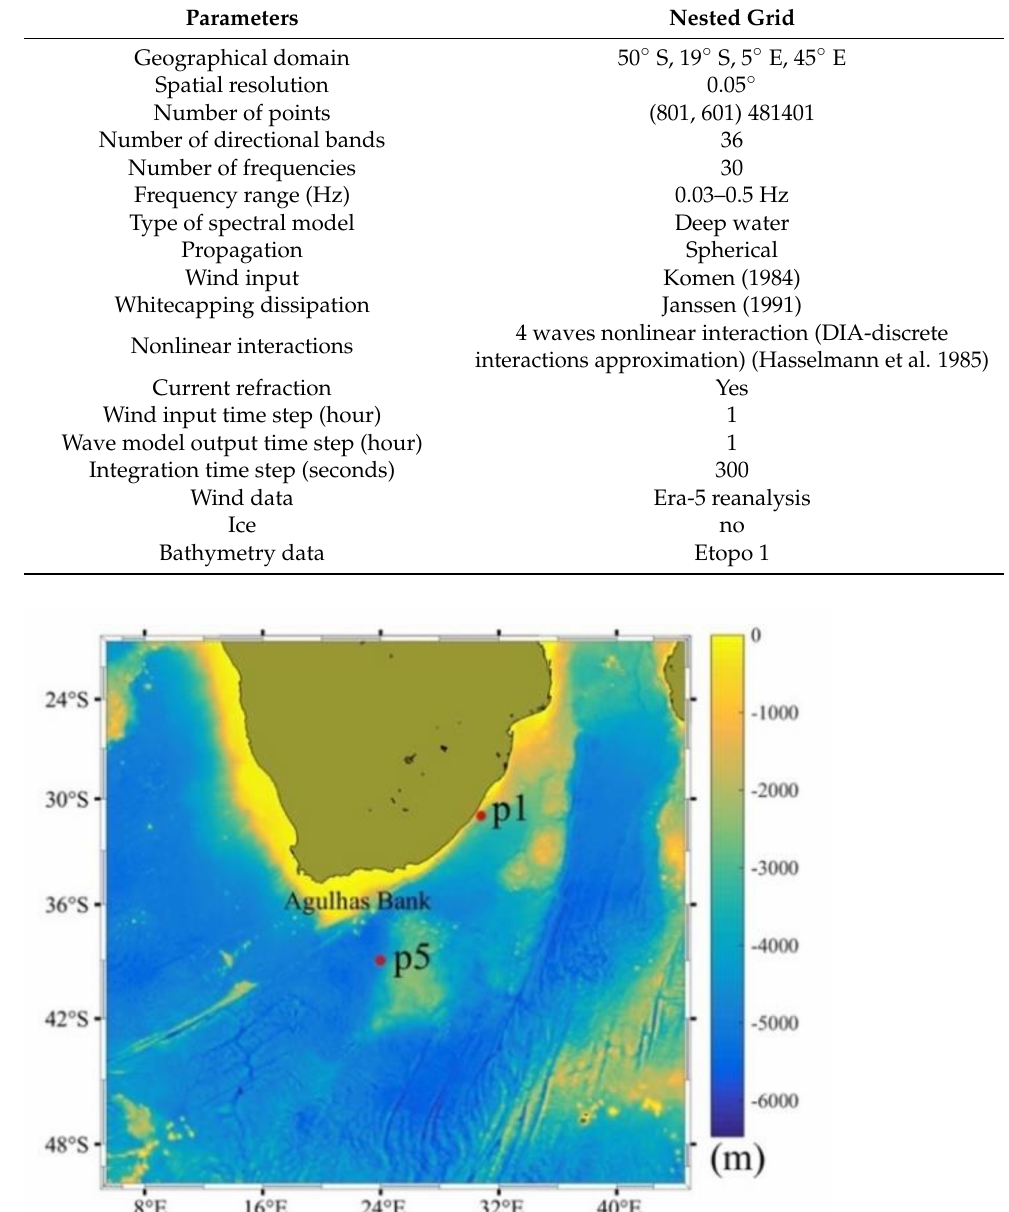
Table 1. Parameters of the SWAN model implementation for the Agulhas Current region.